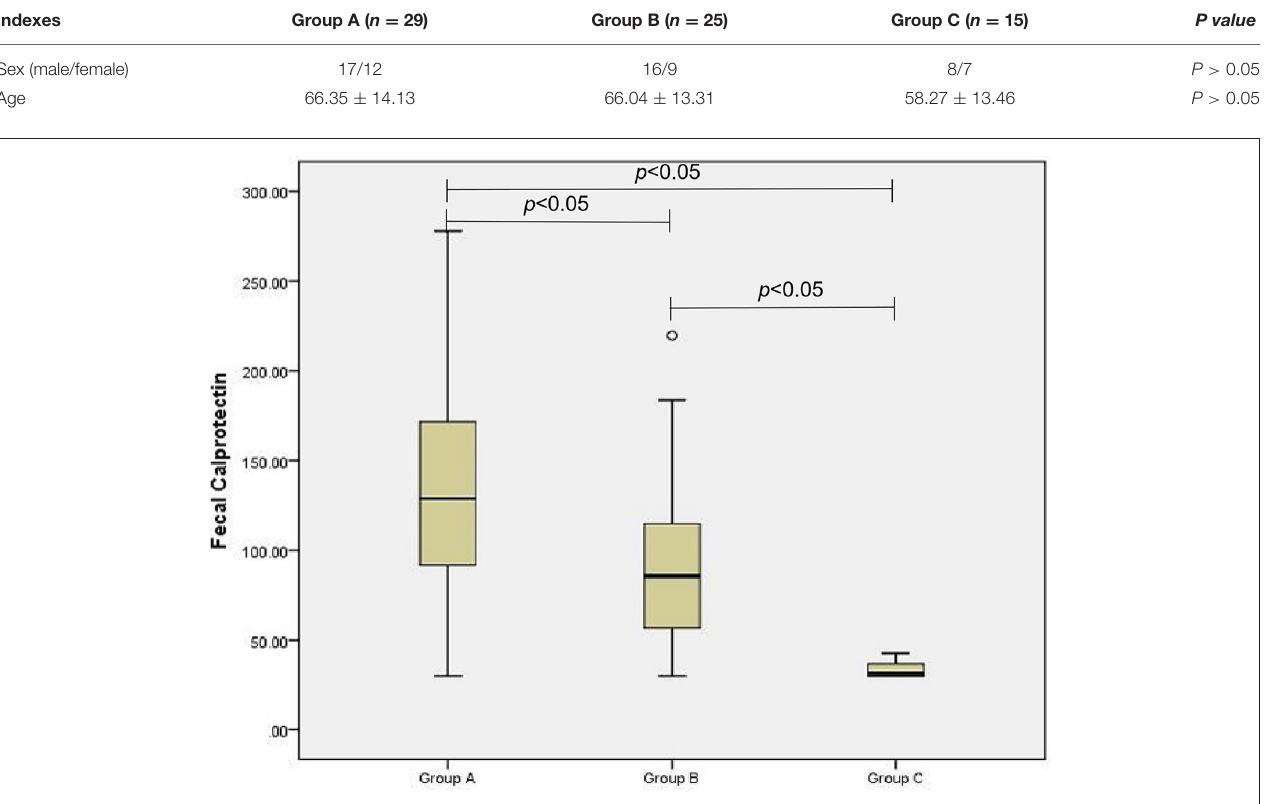
FIGURE 1 | Comparison of fecal calprotectin levels in group A, B, and